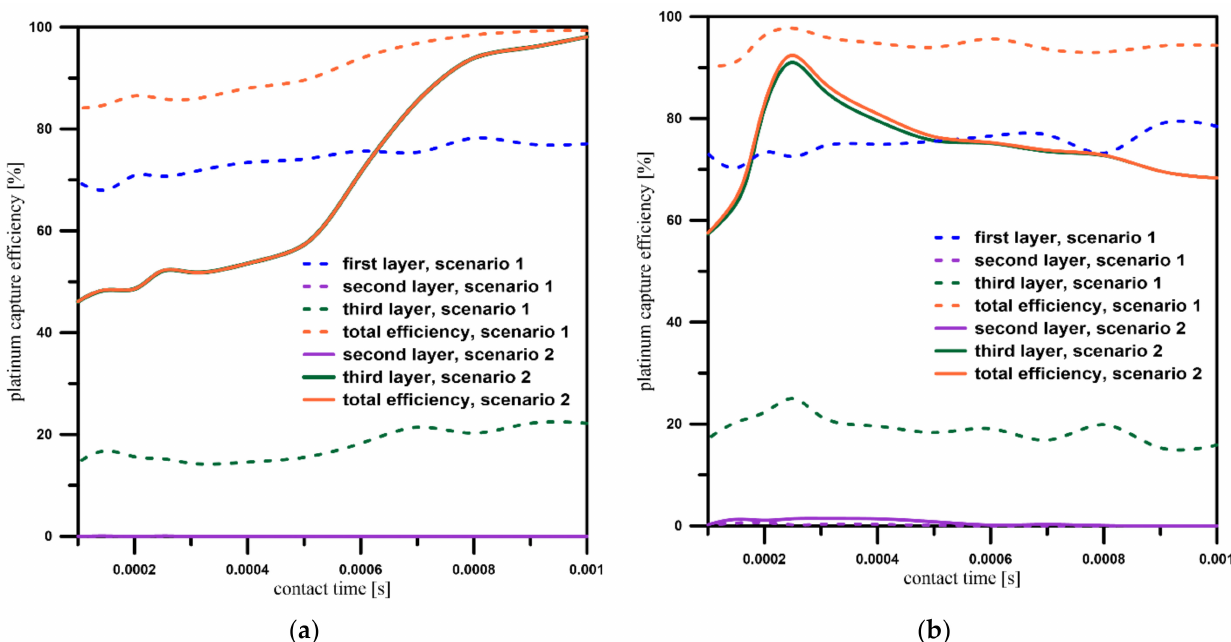
Figure 11. Efficiencies of platinum capture as a function of contact time for Geometry A ( a ) and Geometry B ( b ).